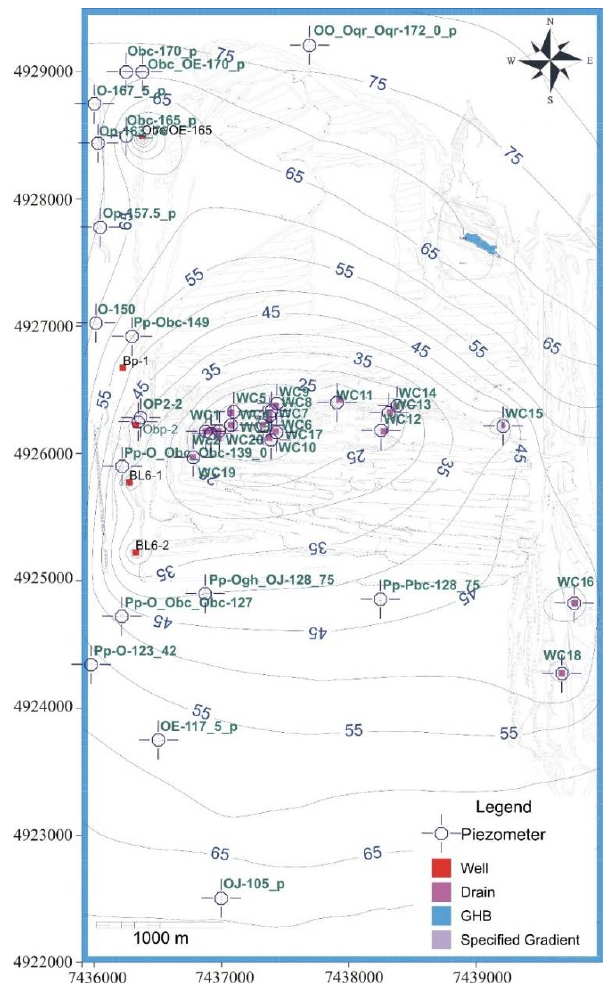
Figure 17. Groundwater levels of the lower aquifer (7th modeled layer)—June 2015.